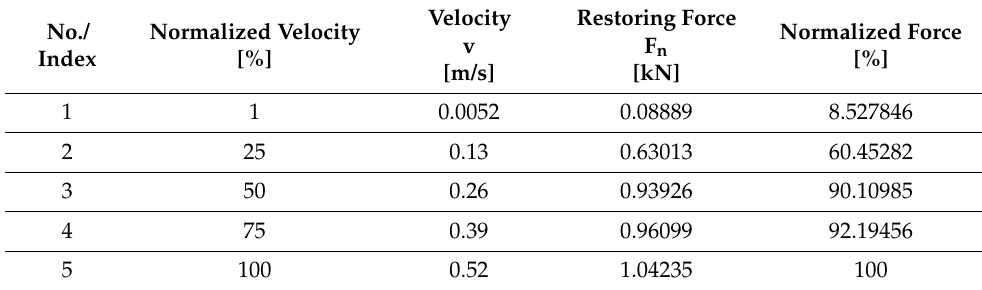
Figure 5. Normalized force vs. normalized velocity. A typical constitutive law of an FSD, from the standard EN 15129 [1], has the equa- tion: